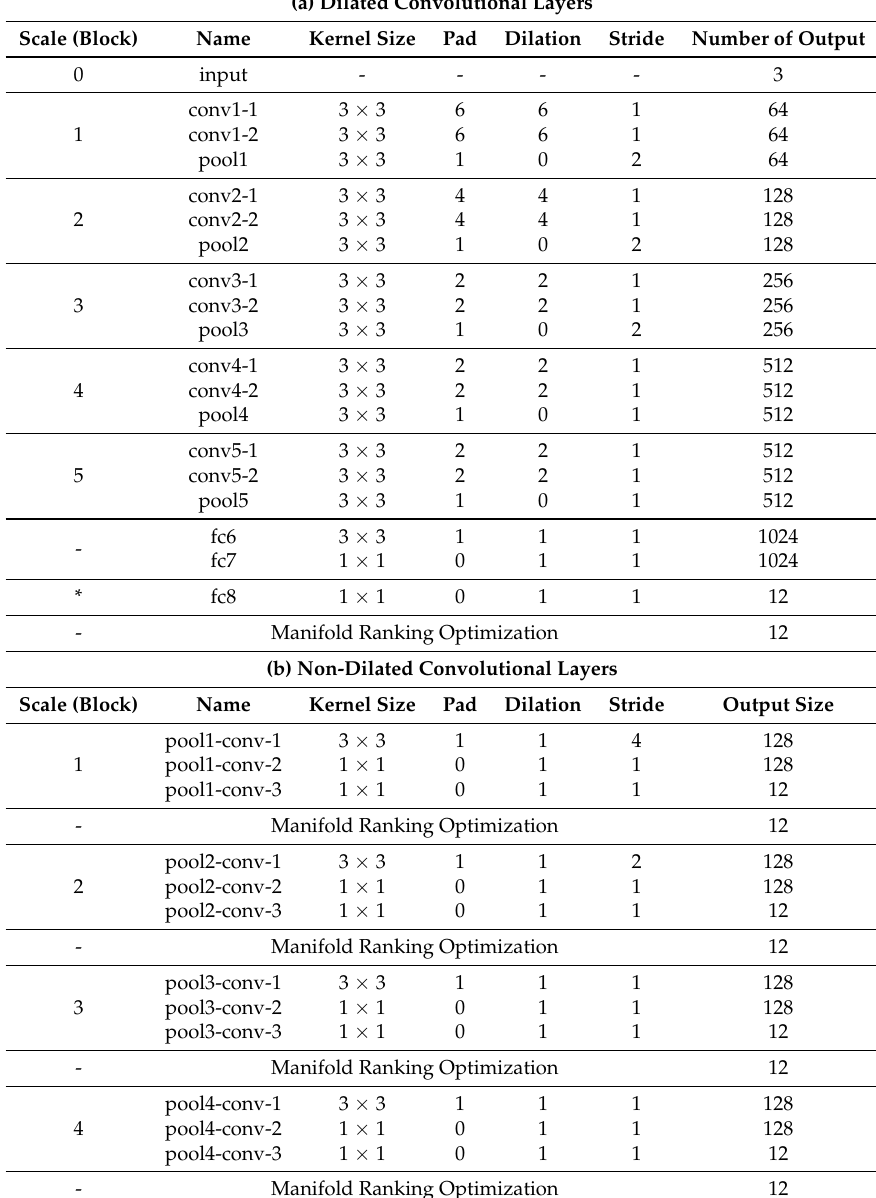
Table 1. Detailed implementation of the DMSMR